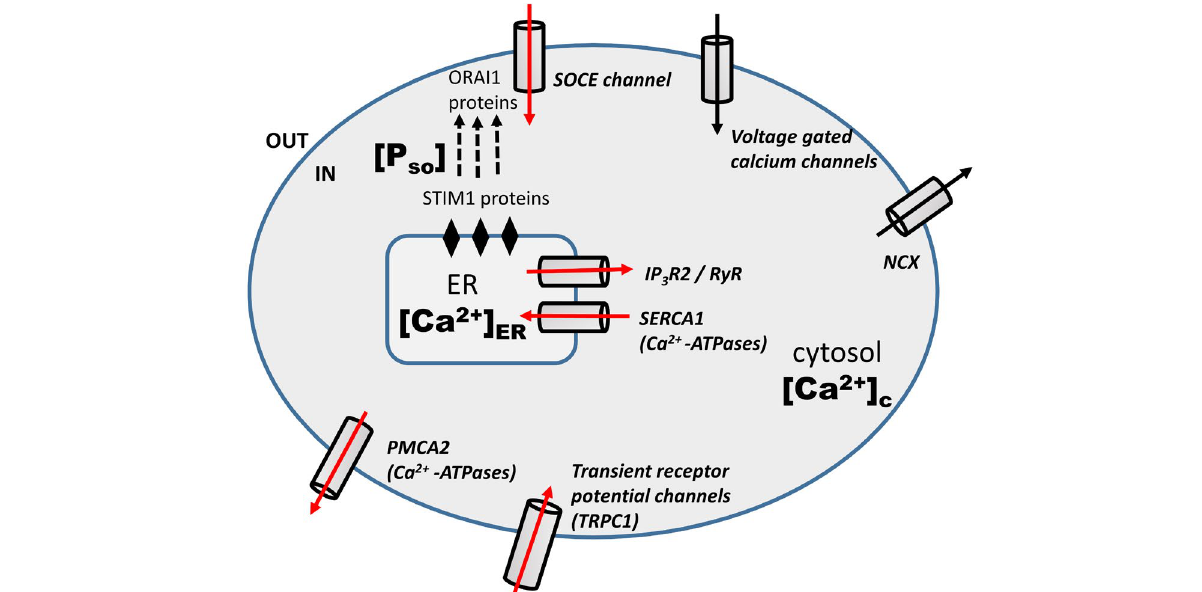
Figure 1. Schematic diagram: Doxo-induced modulation of calcium signaling pathways in TNBC cells [13]. The red arrow represents the increased mRNA level of calcium regulators during Doxo